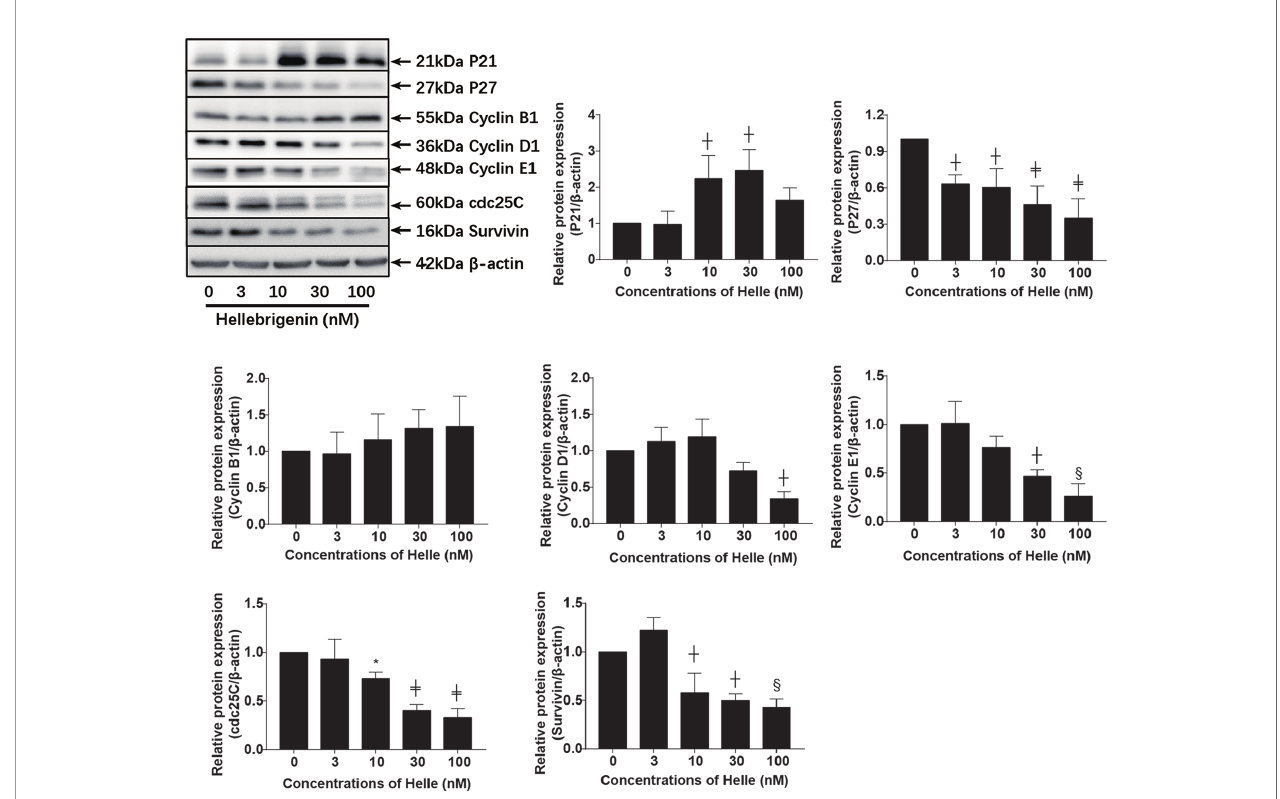
FIGURE 6 | Effect of Helle on the expression level of cell cycle related-proteins in MCF-7 cells. After treatment with various concentrations of Helle (3, 10, 30 and 100 nM) for 48 h, the expression levels of cell cycle-related proteins were analyzed by western blotting. The relative expression levels were expressed as the ratios between each target gene protein and b -actin protein expression levels, and compared with those of untreated control group, respectively. Data are presented as the means ± SD from three independent experiments. *p < 0.05; ┼ p < 0.01; § p < 0.001; ╪ p < 0.0001 vs.